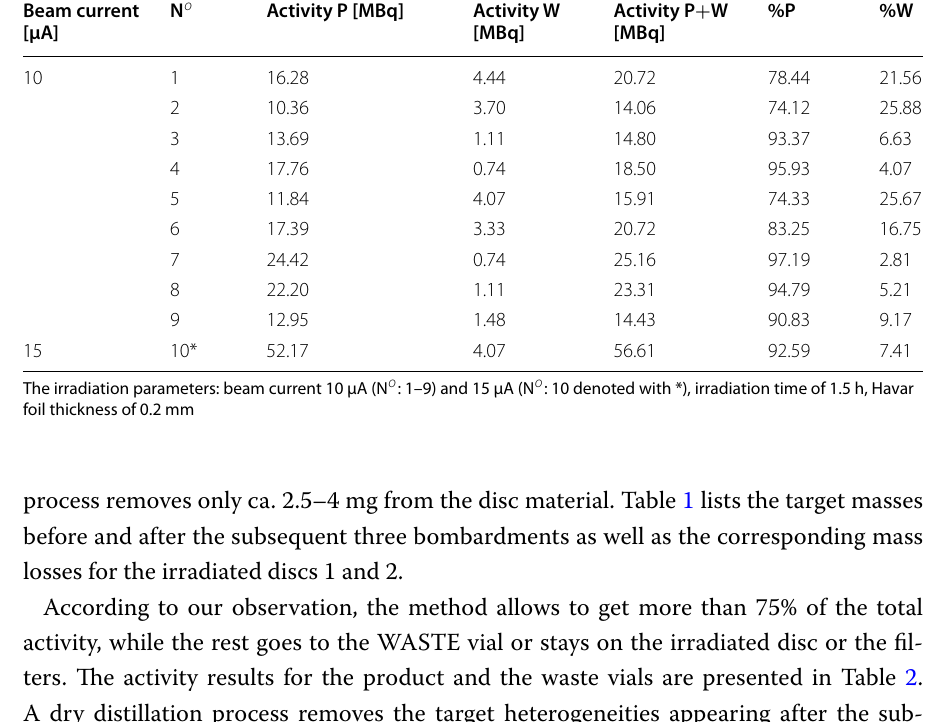
Table 2 Production efficiency at the end of the separation, the product (P) and waste (W) activities Beam current N [μA]